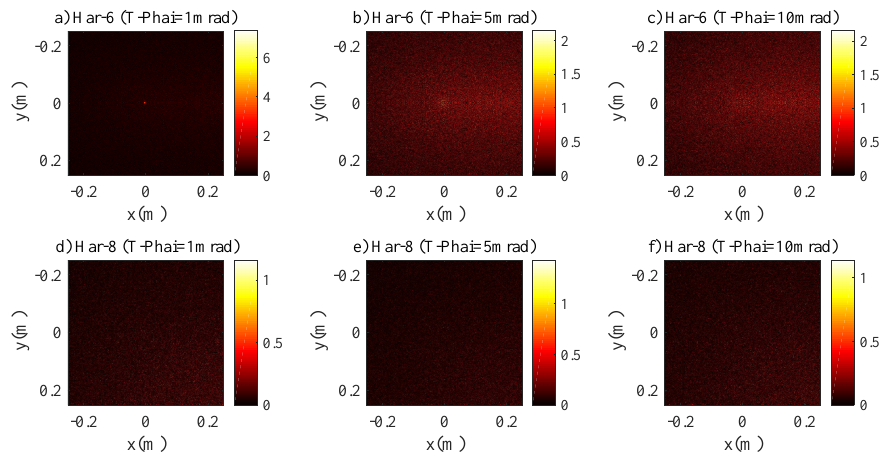
Figure 13. The 2D intensity distribution of a laser beam for harbor seawater channel ( a ) Har-6 with T-Phai = 1 mrad, ( b ) Har-6 with T-Phai = 5 mrad, ( c ) Har-6 with T-Phai = 10 mrad, ( d ) Har-8 with T-Phai = 1 mrad, ( e ) Har-8 with T-Phai = 5 mrad and ( f ) Har-8 with T-Phai = 10 mrad.